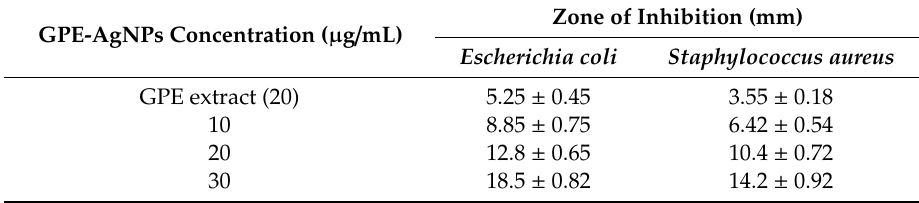
Table 2. In vitro antibacterial activity of grape pomace extract (GPE) and synthesized